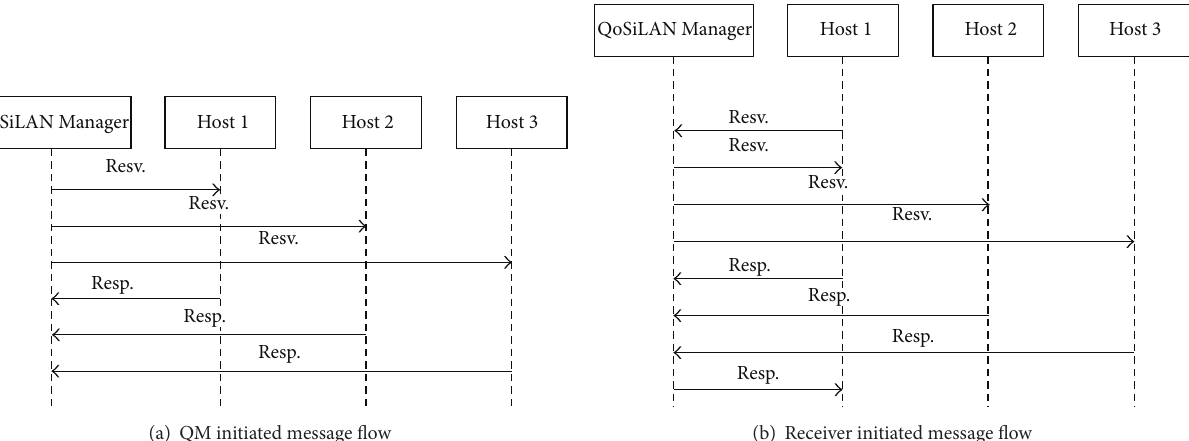
Figure 5: QM and receiver initiated message